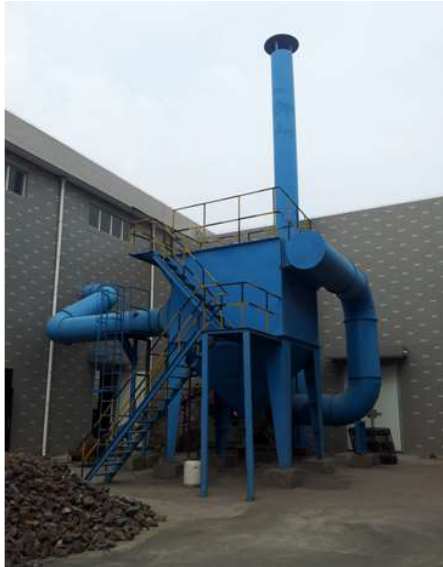
Figure 2. Image of the SCDC.